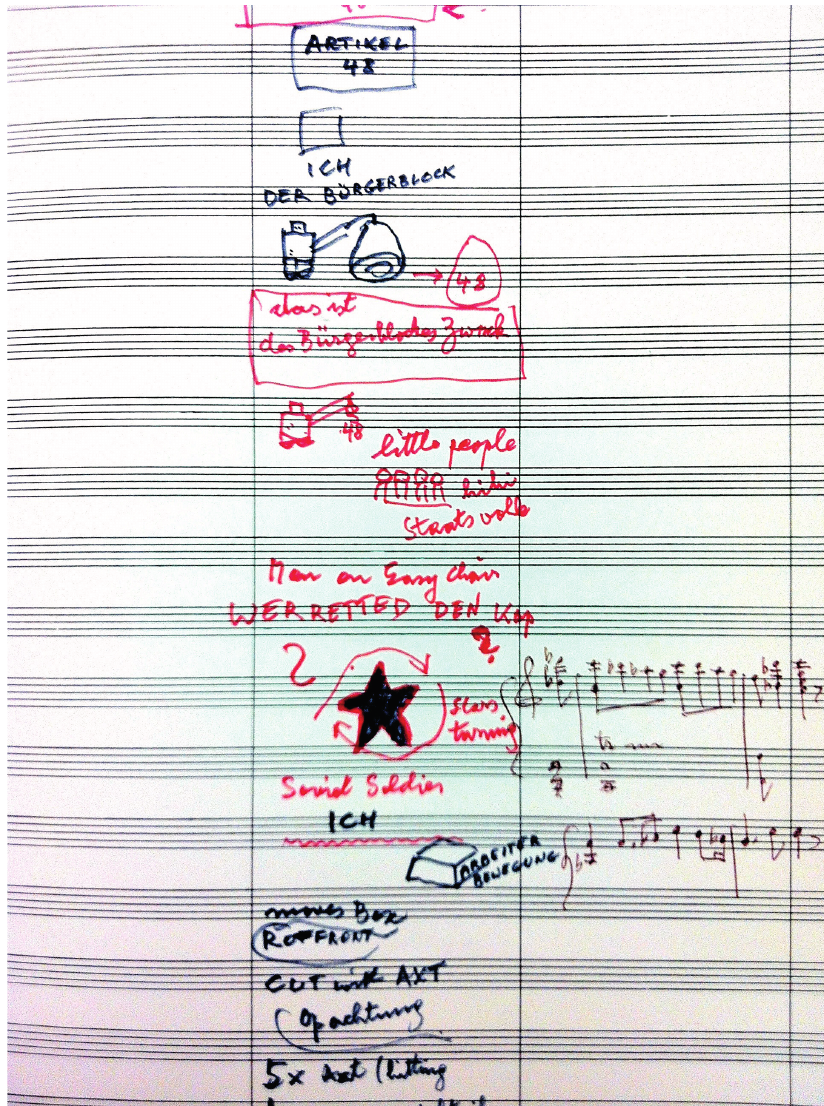
Fig. 1 Sketch for the score to the short film Dem Deutschen Volke , including visual cues (Arthur Kleiner Collection of Silent Movie Music, Films, DE-DR, Box 5, University of Minnesota